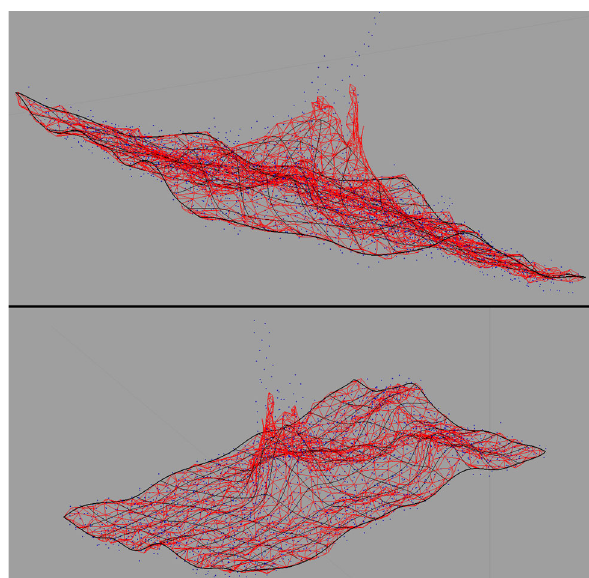
Fig. 7 Irregular part of point cloud (blue) modeled with the mesh network (red) and the NURBS surface patches (black) from two perspectives